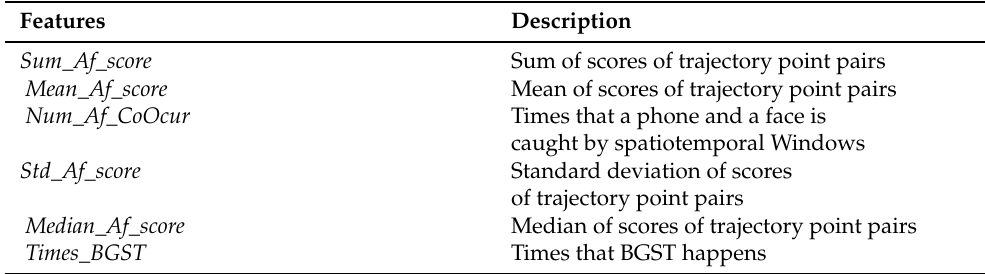
Table 2. Features design for face–phone trajectory matching.